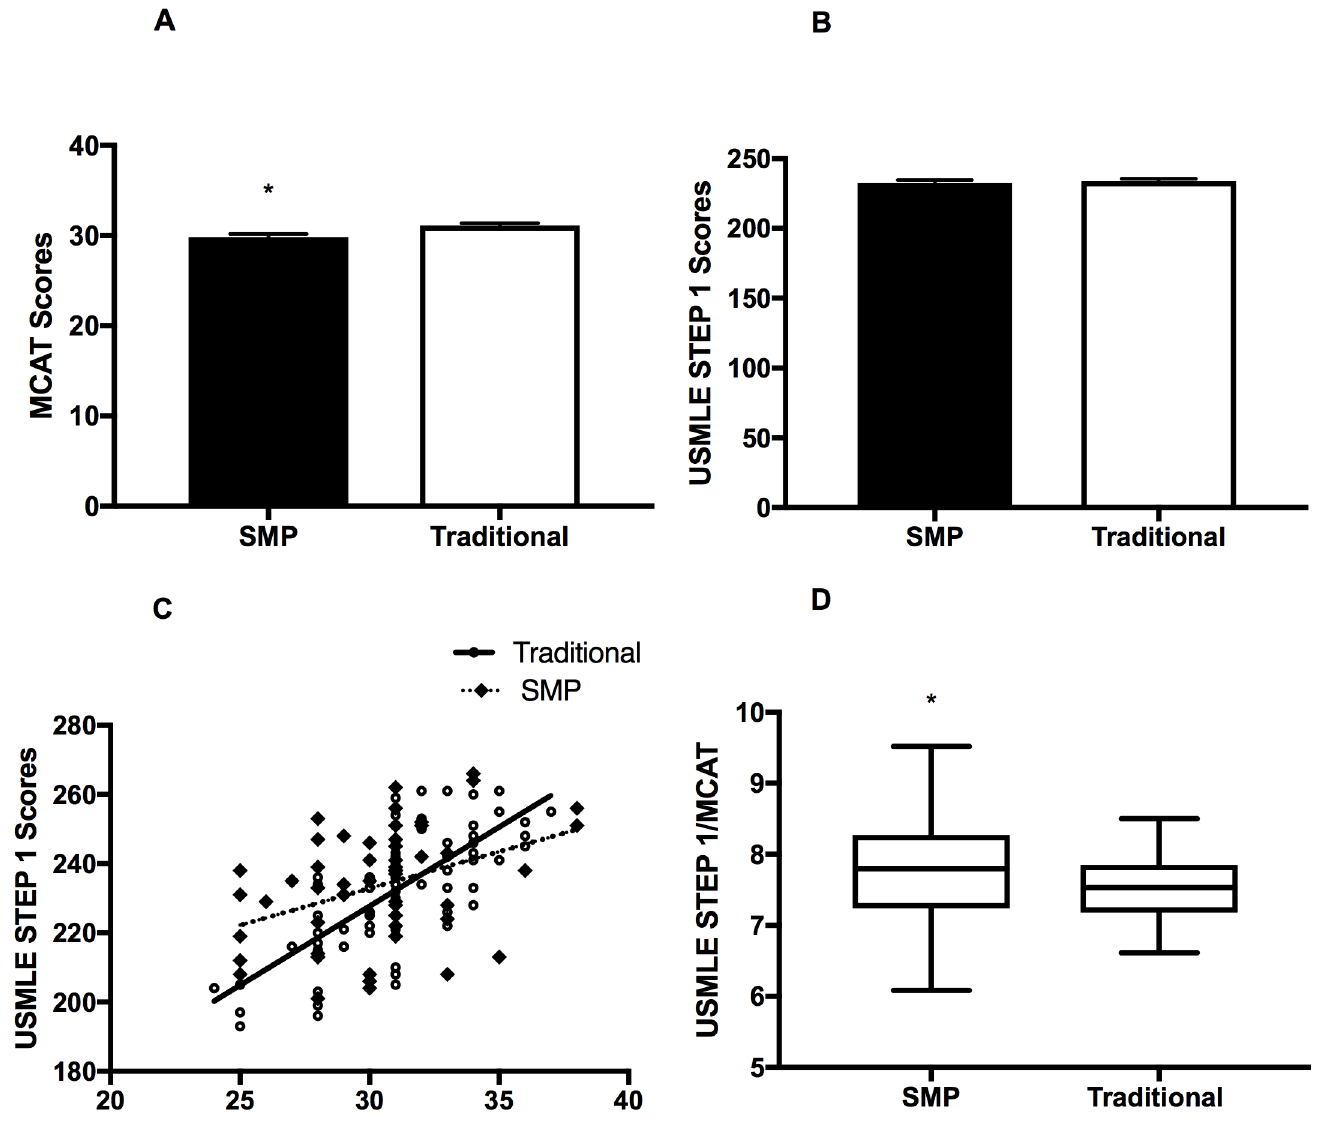
Fig 1. A. Comparative Analysisof MCAT ScoresbetweenSMP andTraditional Students.UnpairedT-Test showsthat MCAT scoresfor incoming TraditionalStudents(mean= 31.1(0.2784SEM), n = 87) are significantlyhigher(p < 0.01)thanincomingSMP Students(mean= 29.9(0.3578),n = 56).B. Comparison of USMLESTEP 1 ScoresbetweenSMP andTraditionalStudents. UnpairedT Test showsthat USMLESTEP 1 scores of SMP (mean= 232.7 (2.091SEM), n = 54) andTraditionalStudents(mean= 233.8(1.616SEM), n = 82) are not significantlydifferent. C. MCAT vs. USMLESTEP 1 Plotand Trendsof SMP andTraditional Students.Linearregression analysisof MCAT andSTEP 1 scoresin SMP Students (slope= 2.126,r 2 = 0.1473,n = 54) and TraditionalStudents(slope= 4.571,r 2 = 0.5138,n = 77) showsthat the trendsfor the two groupsare significantly (p < 0.01)different.D. Comparison of USMLESTEP 1 Scores, normalized to MCATS, betweenSMP andTraditional Students.UnpairedT test showsthat MCAT-normalized,USMLESTEP 1 scoresof SMP (mean= 7.77(0.10 SEM), n = 54) andTraditionalStudents(mean= 7.51(0.05SEM), n = 77)are significantly( * p < 0.02)different.